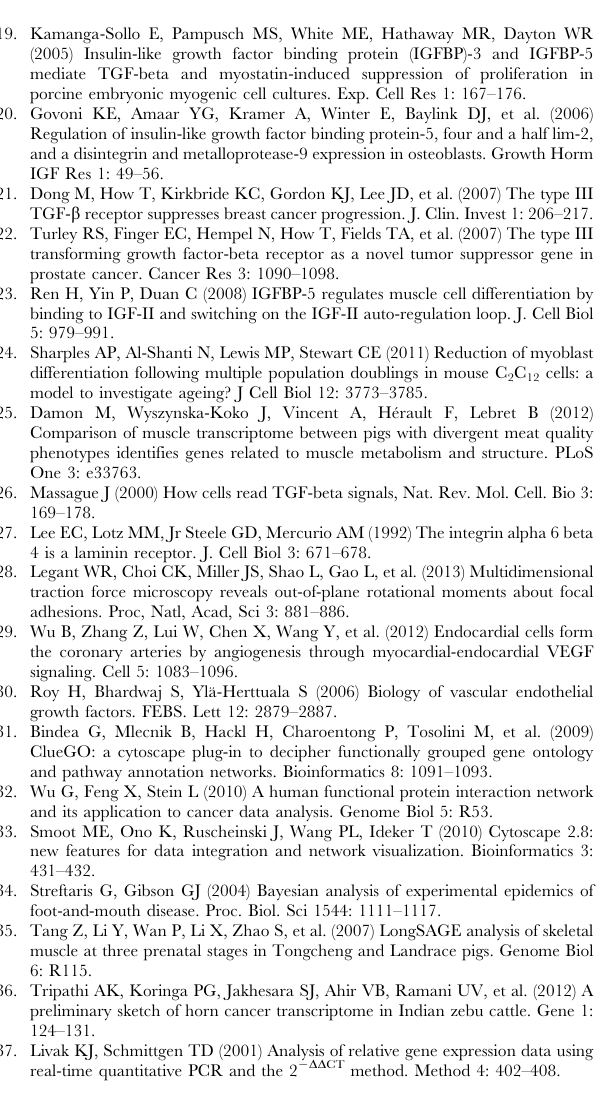
Table S4. The extension of DEGs according to RNA-seq.xls. Table S5. UTR prediction of the DEGs.xlsx. Table S6. Gene symbols for 1300 DEGs.xls. Table S7. UTR sequence of novel transcript units.xlsx. Table S8. Predicted UTR regions of novel transcript untis.xlsx. Table S9. Predicted protein sequences in the two library.xlsx. Figure S1. Gene expression changes in the ECM-receptor interaction. A red frame indicates genes that are up-regulated in the SH sheep compared to the DP sheep, and